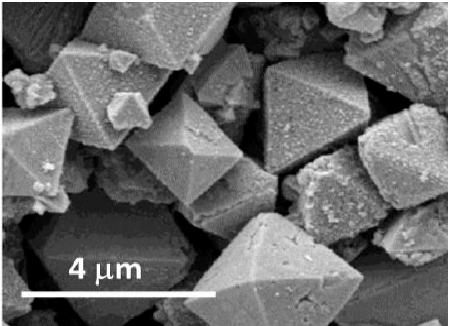
Figure 1. SEM image of SnO 2 octahedra.